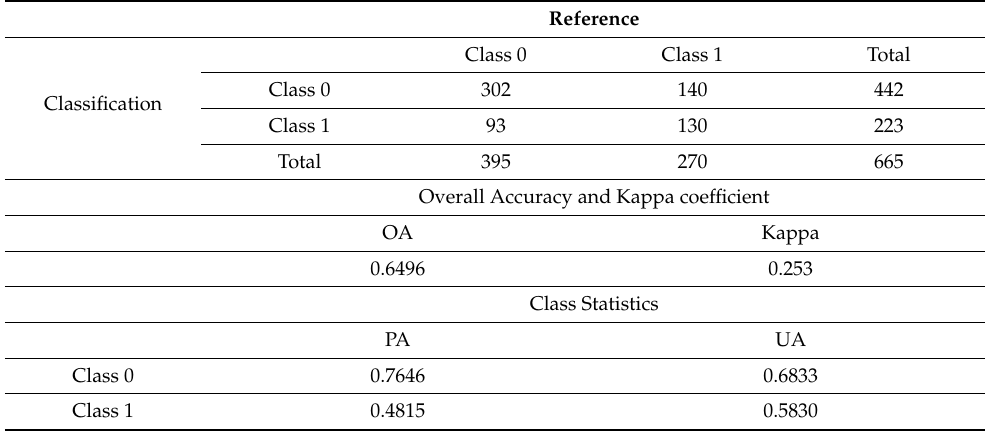
Table A3. Topo classification (“scheme